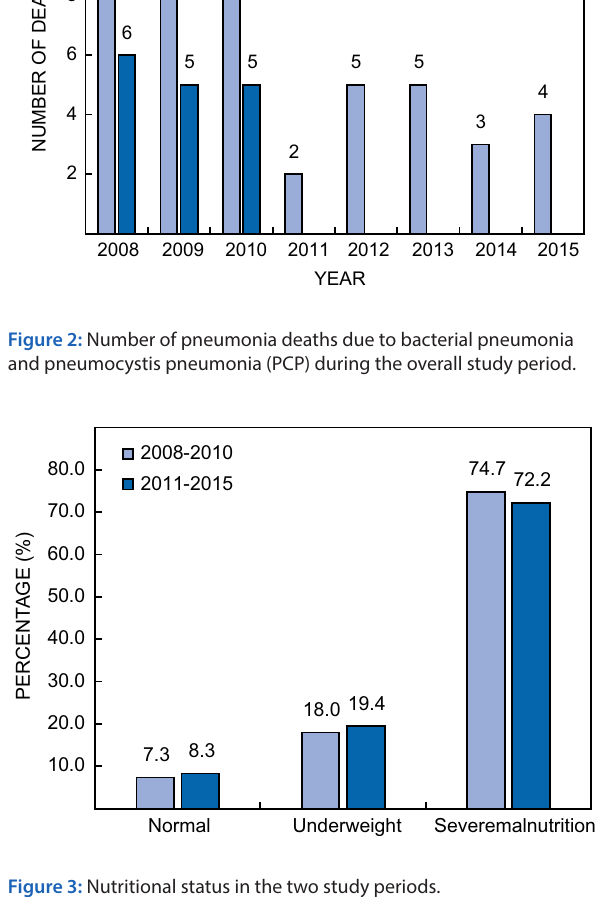
Figure 3: Nutritional status in the two study